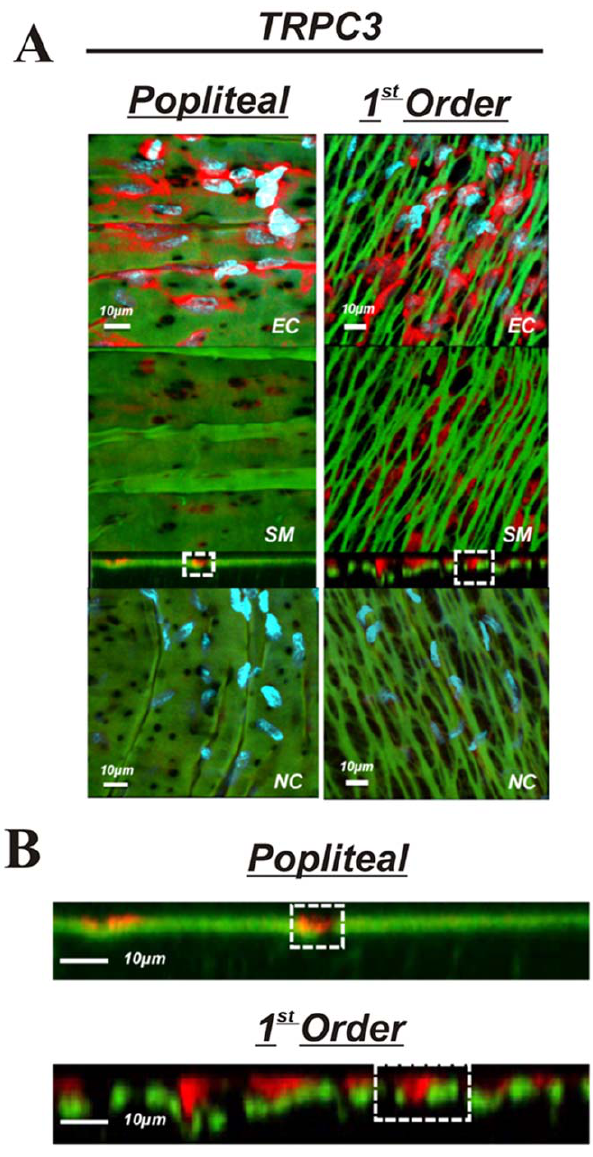
Figure 8. TRPC3 in skeletal muscle arteries. A: skeletal muscle popliteal (left) and 1 st order (right) arteries immunolabeled for TRPC3 (top 3 panels) or no primary antibody control (bottom panel). The top image represents a composite of DAPI-stained nuclei in the endothe- lium, autofluorescence of the internal elastic lamina (green), and TRPC3 immunolabeling immunolabeling (red), and a compressed z-stack image endothelial cell surface (EC, top panel). The second image is a compressed z-stack image from the perspective of the smooth muscle face (SM), the third image is a cross-sectional slice, and the fourth is a compressed z-stack image of a no primary antibody control (NC).Red staining indicates endothelial expression of TRPC3. B: Magnified image of the cross-sectional view of the IEL. Note the sections highlighted by dotted square boxes indicating larger MEC and area of TRPC3 staining in 1 st order arterioles. Bar=10 m m. Representative of images from tissue isolated from at least 3 animals.